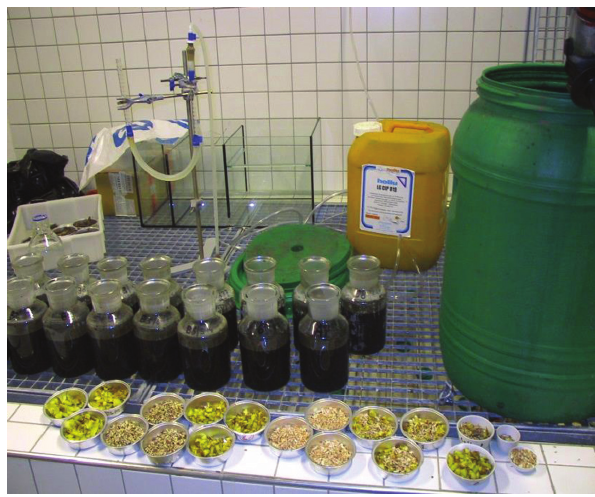
Figure 4 Organic waste from food industry prepared for biogas